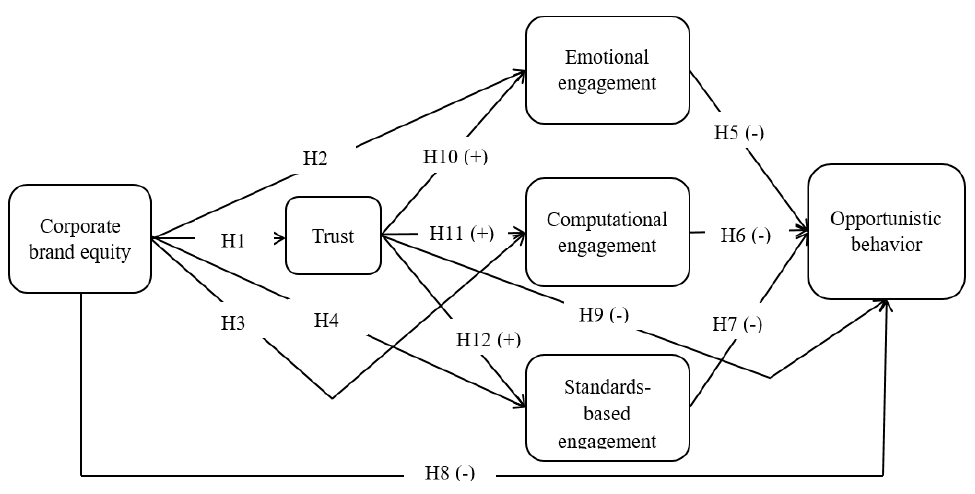
Figure 1. Research model.